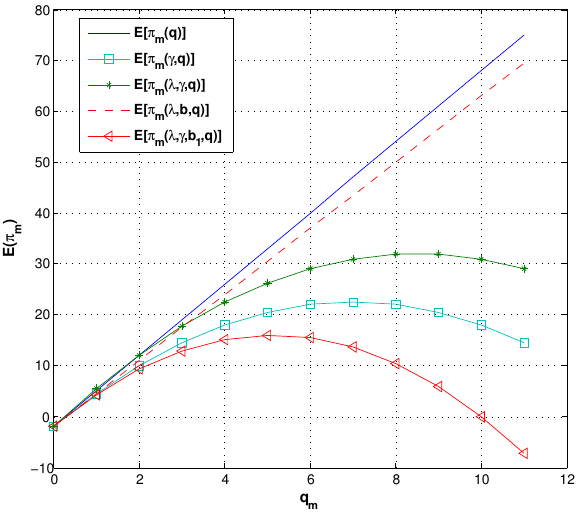
Figure 7. The expected profit of the manufacturer under different